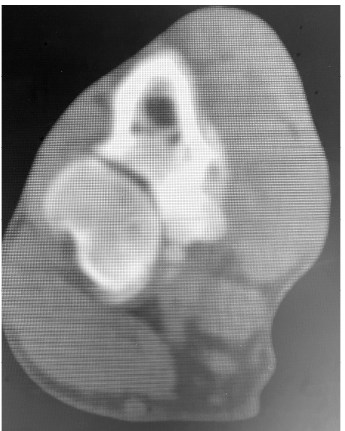
Figure 1. CT image of case 1 treated with MCDE. Note the small and misshapen medial coronoid process with decreased density and separated from the adjacent bone.